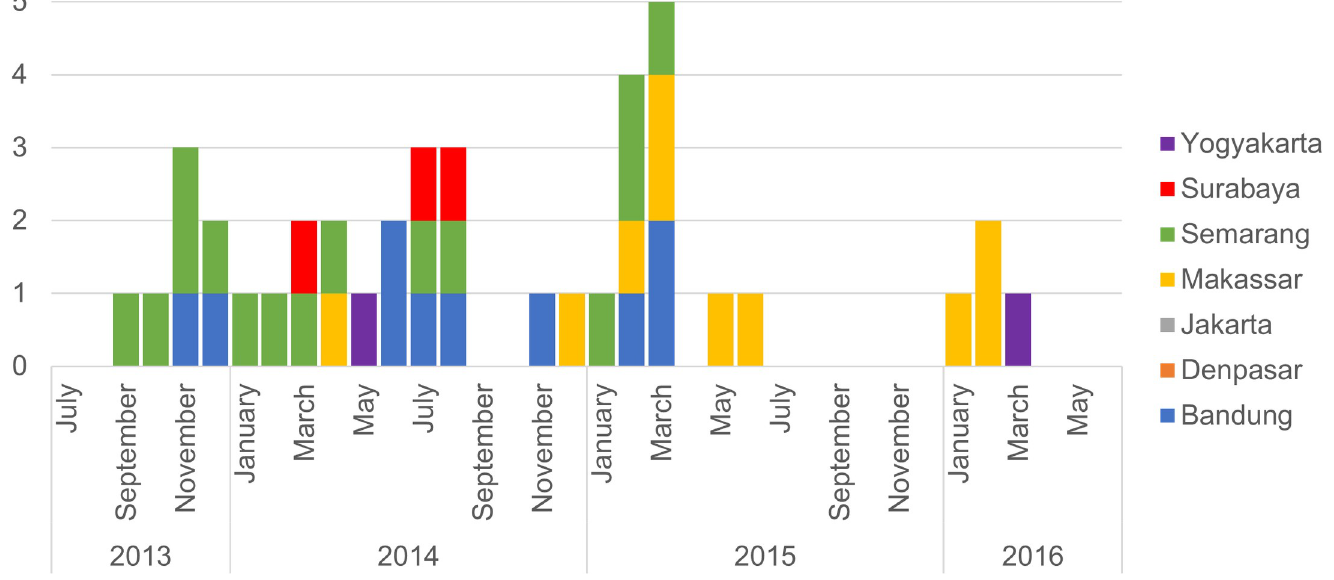
Fig 3. Distribution of acute chikungunya infection cases by month and